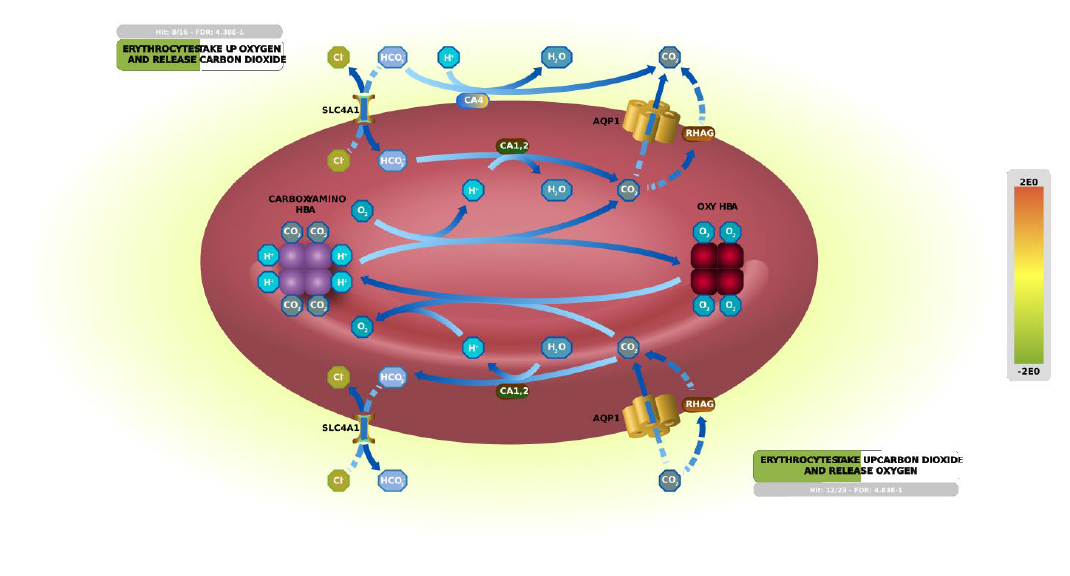
Figure 4. Enhanced high-level Reactome pathway diagram for O 2 /CO 2 exchange in erythrocytes 59 by expression overlay with the MGI RNA-seq Post7 dataset (credit: Jassal B and May B at European Bioinformatics Institute; New York University Langone Medical Center; Ontario Institute for Cancer Research; Oregon Health and Science University). This high-level diagram represents two subpathways, namely erythrocyte take up oxygen and release carbon dioxide and erythrocyte take up carbon dioxide and release oxygen. The green band indicates the proportion of the pathway that is represented in the MGI RNA-seq Post7 dataset, and the colour (green) represents the down-regulation of the pathway genes. The grey bar contains the information on the number of pathway entities in the query dataset, the total number of the pathway entities, and the FDR corrected over-representation